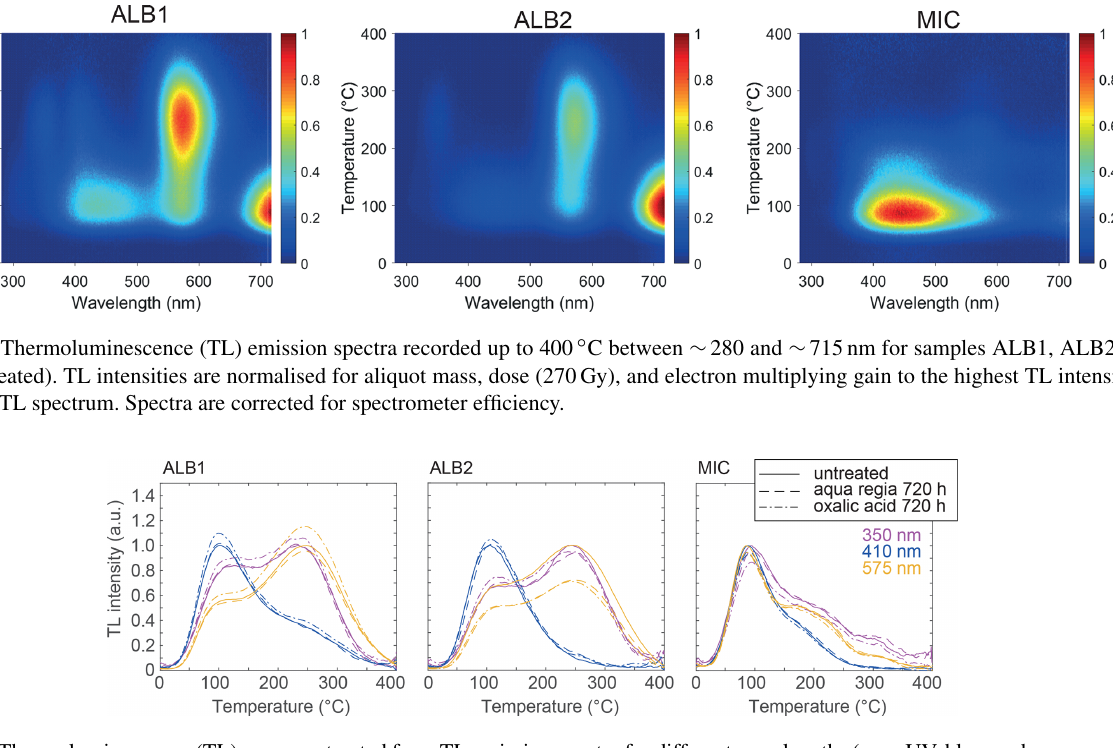
Figure 4. Thermoluminescence (TL) curves extracted from TL emission spectra for different wavelengths (near-UV, blue, and green–yellow) for the untreated specimens and the chemically treated samples for 720h using aqua regia (dashed line) and oxalic acid (dashed–dotted line). The aqua regia and oxalic acid spectra were normalised to the untreated sample (solid line) of each specific wavelength region for comparison. All curves show the mean values measured from three